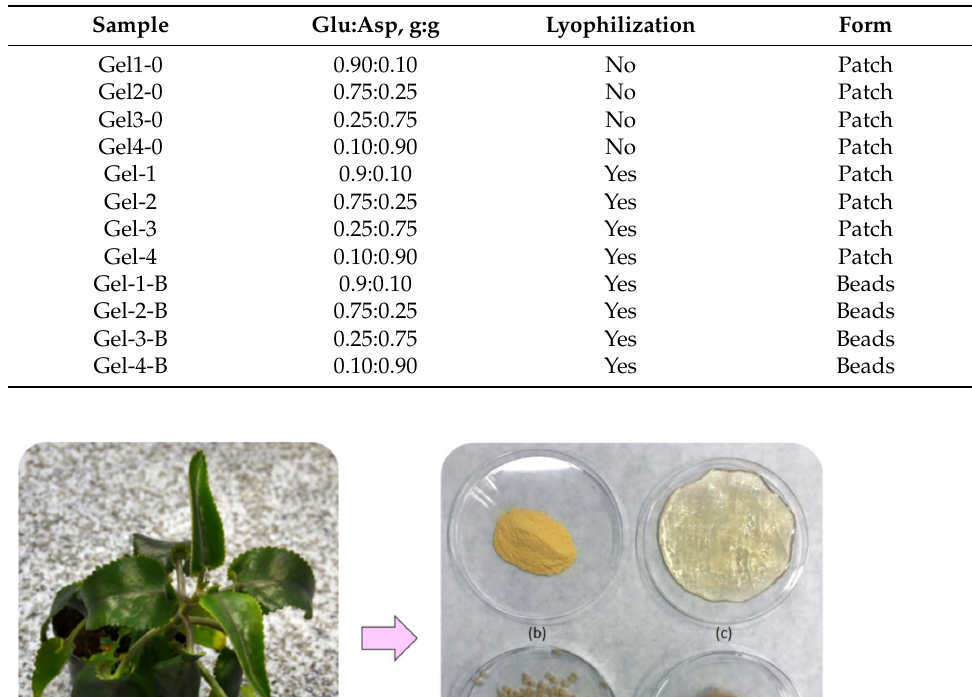
Table 1. Samples description and composition.